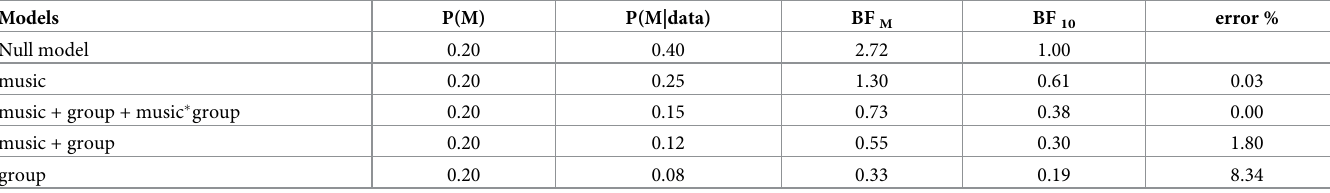
Table 4. Comparison of Bayes models: Music &